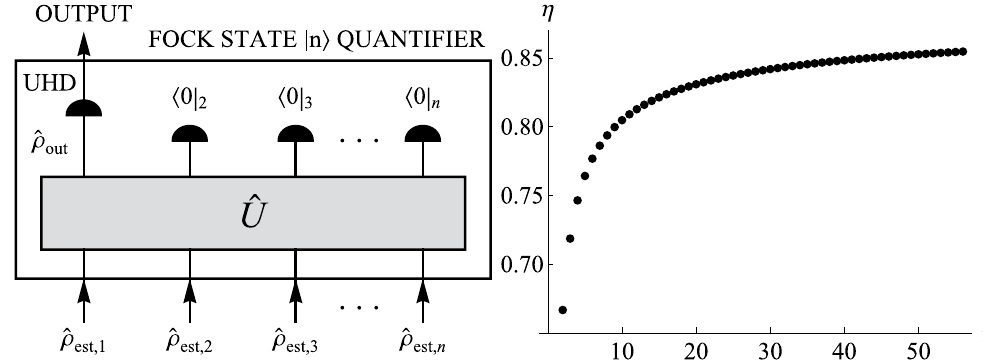
Figure 1. (LEFT) A pictorial representation of a physical procedure to derive the operational quantifier, processing n independent estimates of the density matrix ρ ˆ , in terms of virtual physical operations: ˆ U - the est i , virtual unitary transformation representing a linear optics network, 〈 0| i - the virtual detection projecting the i - th output mode on vacuum state, UHD - the virtual unbalanced homodyne detection measuring the point values of Wigner function of the output state ρ ˆ after the unitary transformation and the projections on out vacuum. (RIGHT) The sufficient single-photon fraction η for the Fock state | n 〉 capability of the attenuated 0 208243 0 139454 . single-photon state for which M = 1. Data can be fitted by the function η = . − − . . n ( ) 0 88456 th n n The largest deviation of fit function from the computed data is 9 × 10 − 4